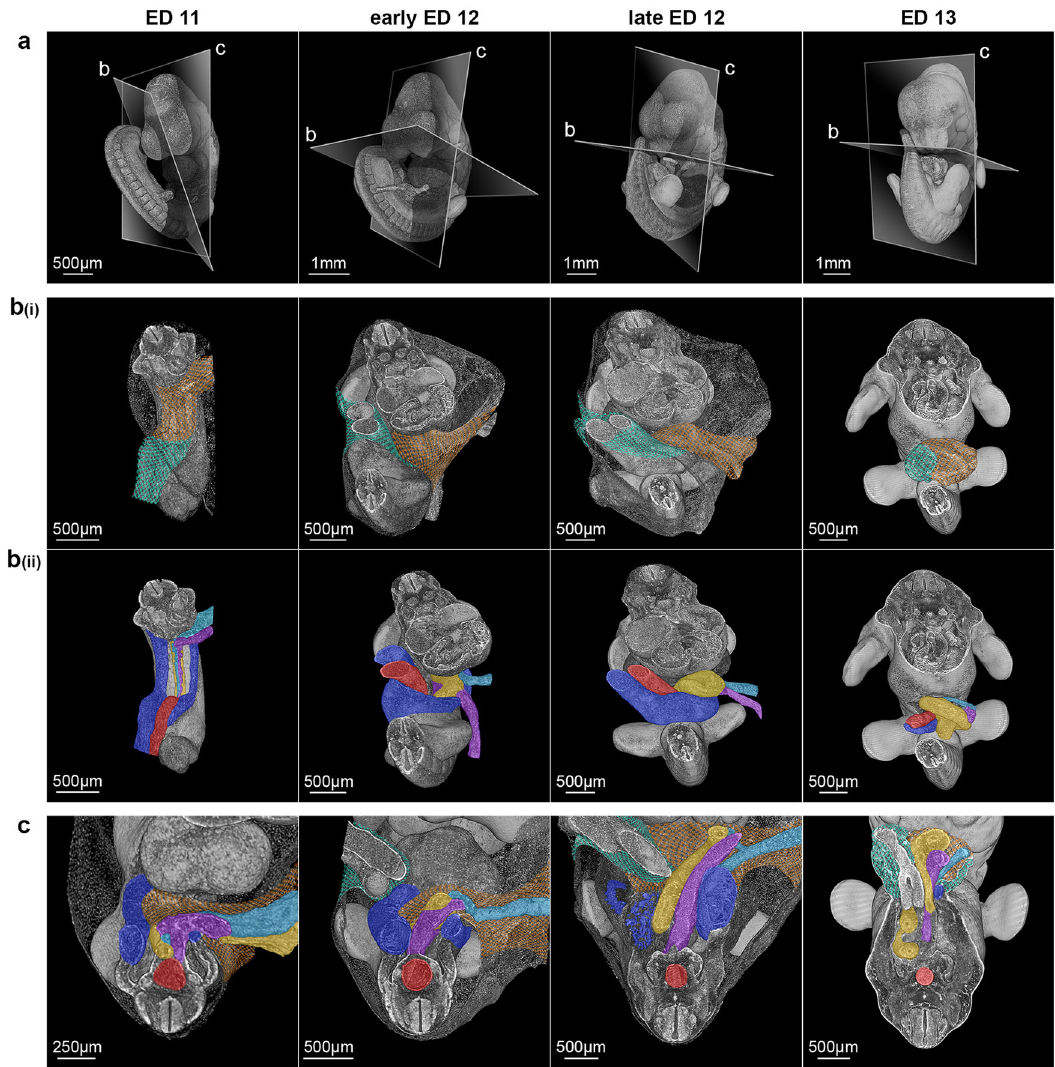
Fig. 2 Formation of the de fi nitive umbilicus. a Representative reconstructions of rat embryos from ED 11 to ED 13 showing embryonic torsion and sectional planes of ( b ) and ( c ). b(i) Ventral view of the amnion-covered umbilical region. Amniotic membranes form two compartments at ED 11 (umbilical compartment: turquoise net; vitelline compartment: orange net), which aggregate during development to ED 13. b(ii) Ventral view after virtual removal of the amniotic membrane. Vessels and the intestine are colorized (intestine/yolk sac channel: yellow; umbilical artery/aorta: red; umbilical veins: blue; vitelline artery: purple; vitelline vein: turquoise). c Transversal section of the embryo in the area of the developing umbilicus. The asymmetric development of the right and left umbilical veins is